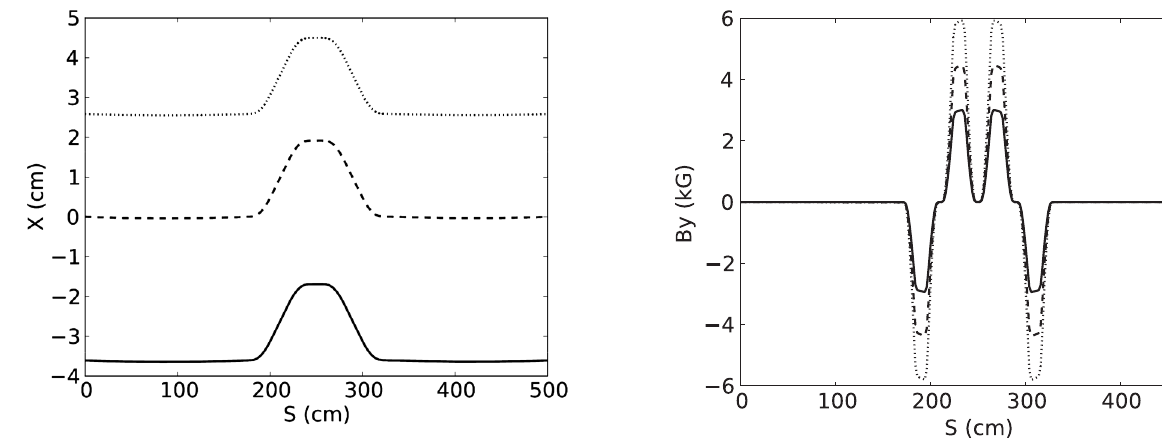
FIG. 56. Fields along the equilibrium orbits at 369, 549, and ¼ 11 and a DF ratio of 1.17. 729 MeV =c through cell with k=x 0 In ascending order of momentum the orbits are shown as solid, dashed, and dotted lines.